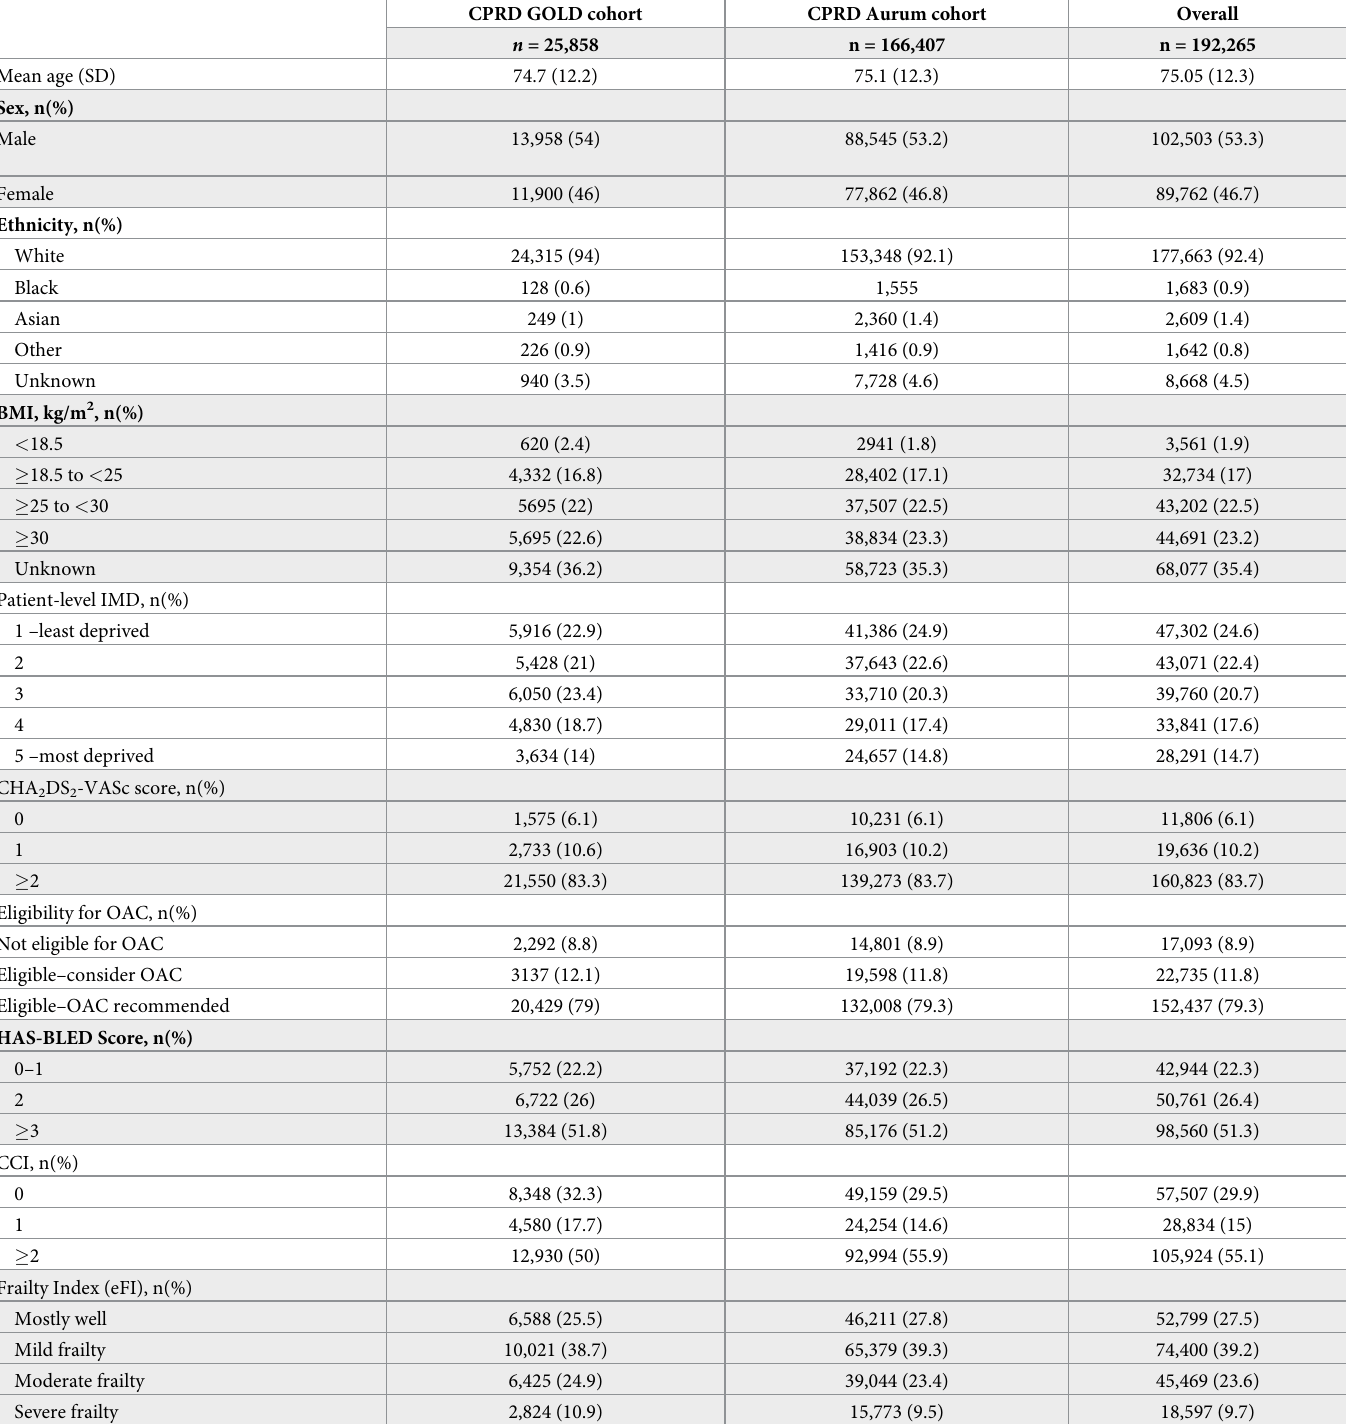
Table 1. Baseline characteristics of patients newly diagnosed with NVAF in England in the CPRD, from 2009 to